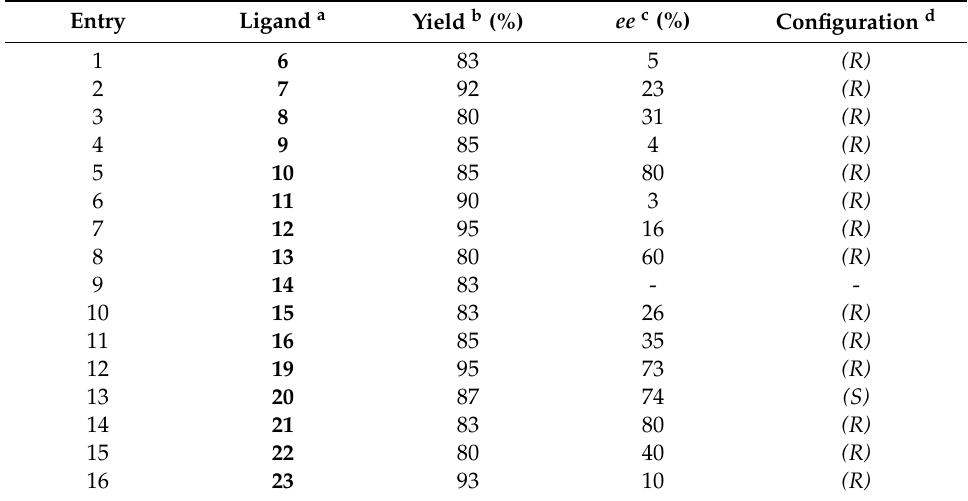
Table 2. Addition of diethylzinc to benzaldehyde, catalyzed by aminodiol derivatives.